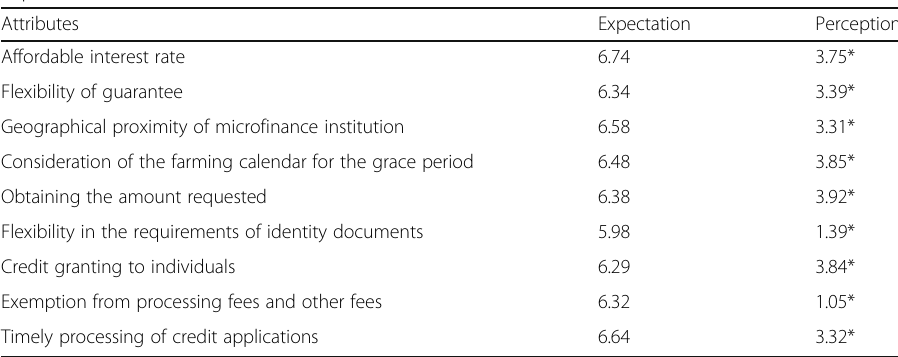
Table 2 Results of Wilcoxon test on the difference between the mean scores of perception and